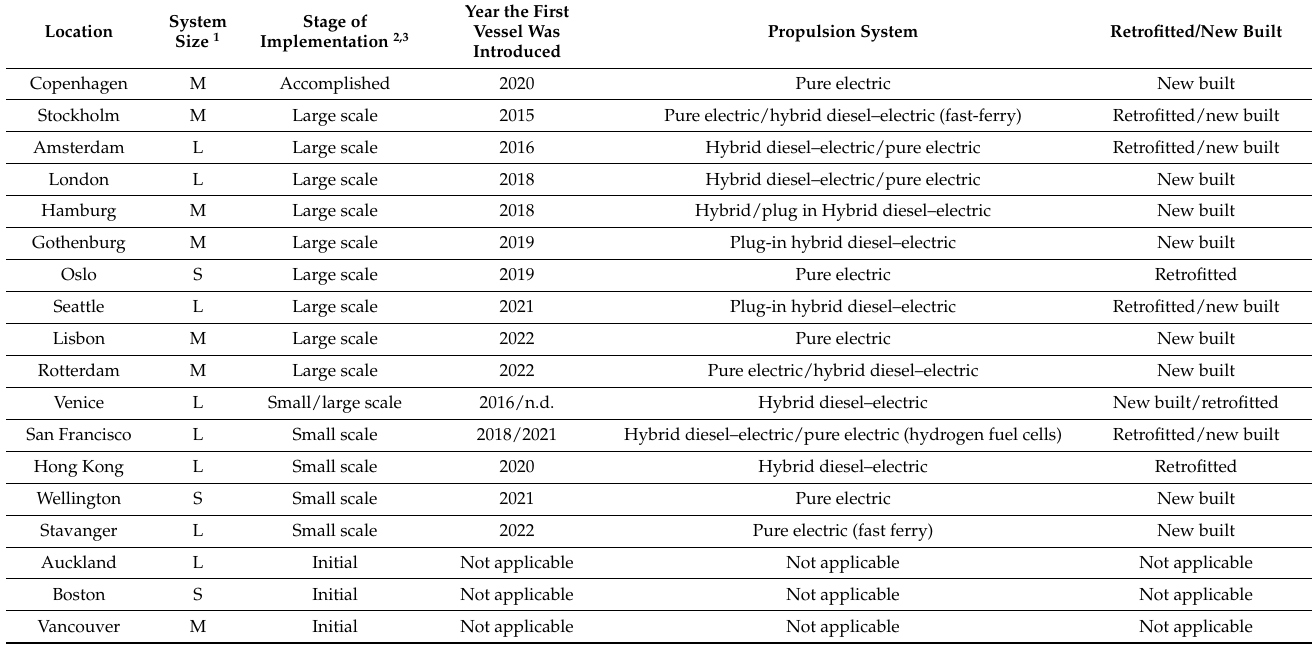
Table 1. Progress in urban water transit electrification (as of